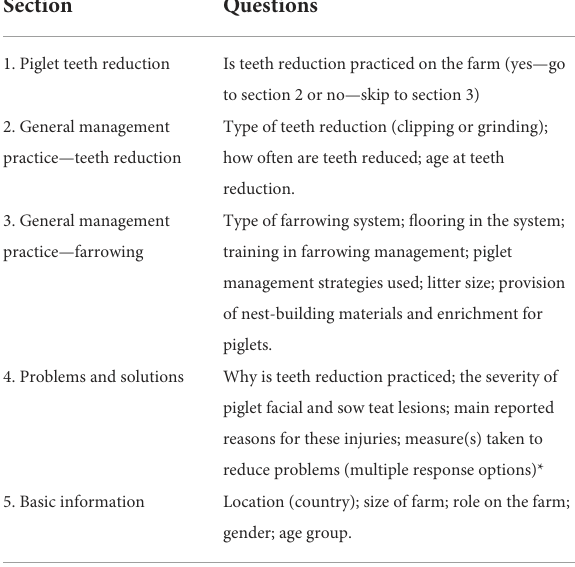
TABLE 1 A summary of the survey sections and questions for the online piglet teeth reduction